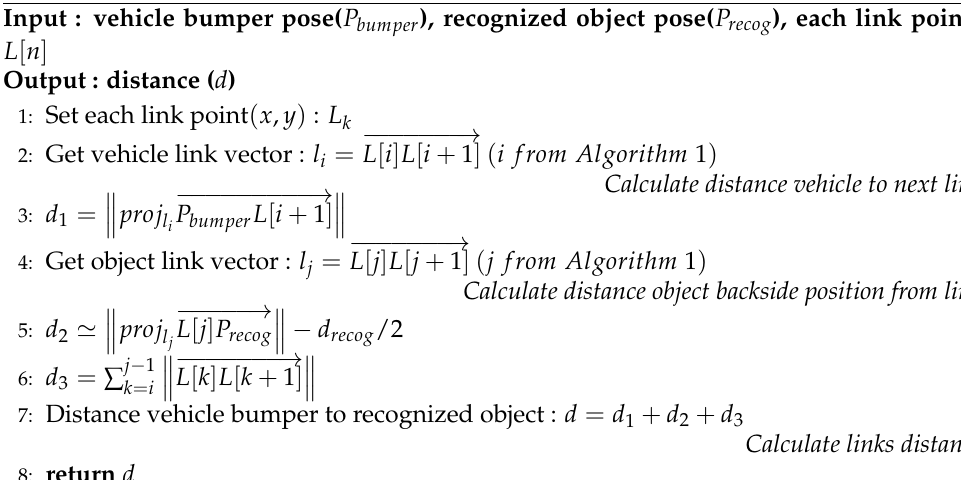
Algorithm 4 Calculate distance from recognized object